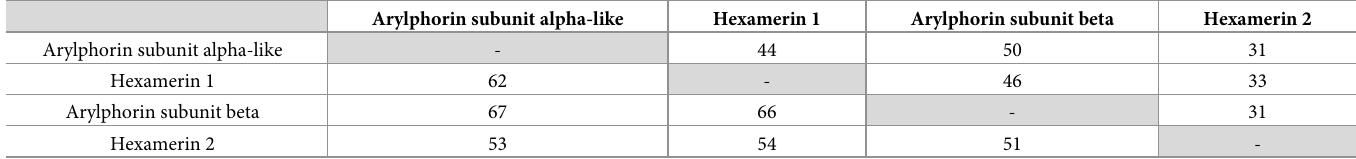
Table 2. Percentage sequence identities and similarities among the S . invicta hexamerins determined by BlastP analyses. Identities are shown above, similarities below the diagonal line represented by shaded